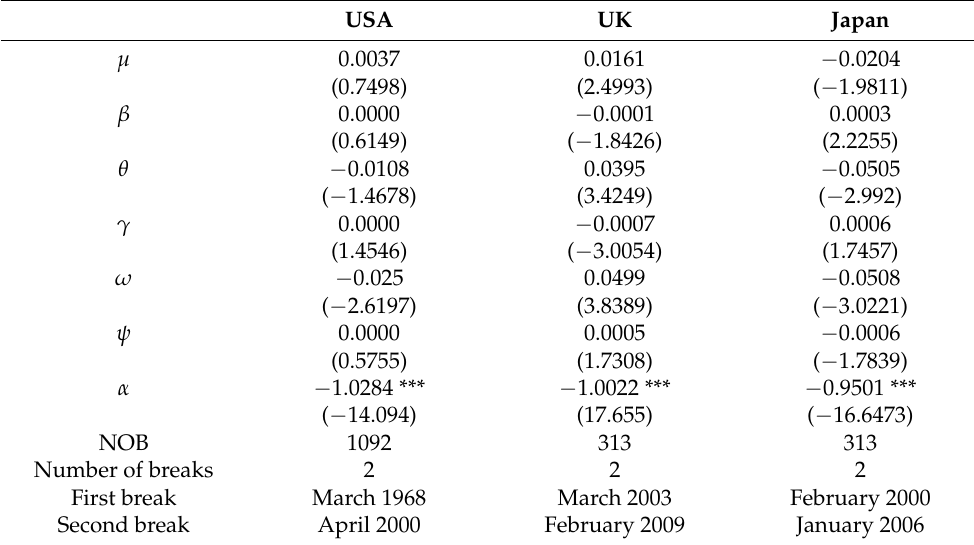
Table 6. Multiple-break unit root tests: Lumsdaine–Papell test.